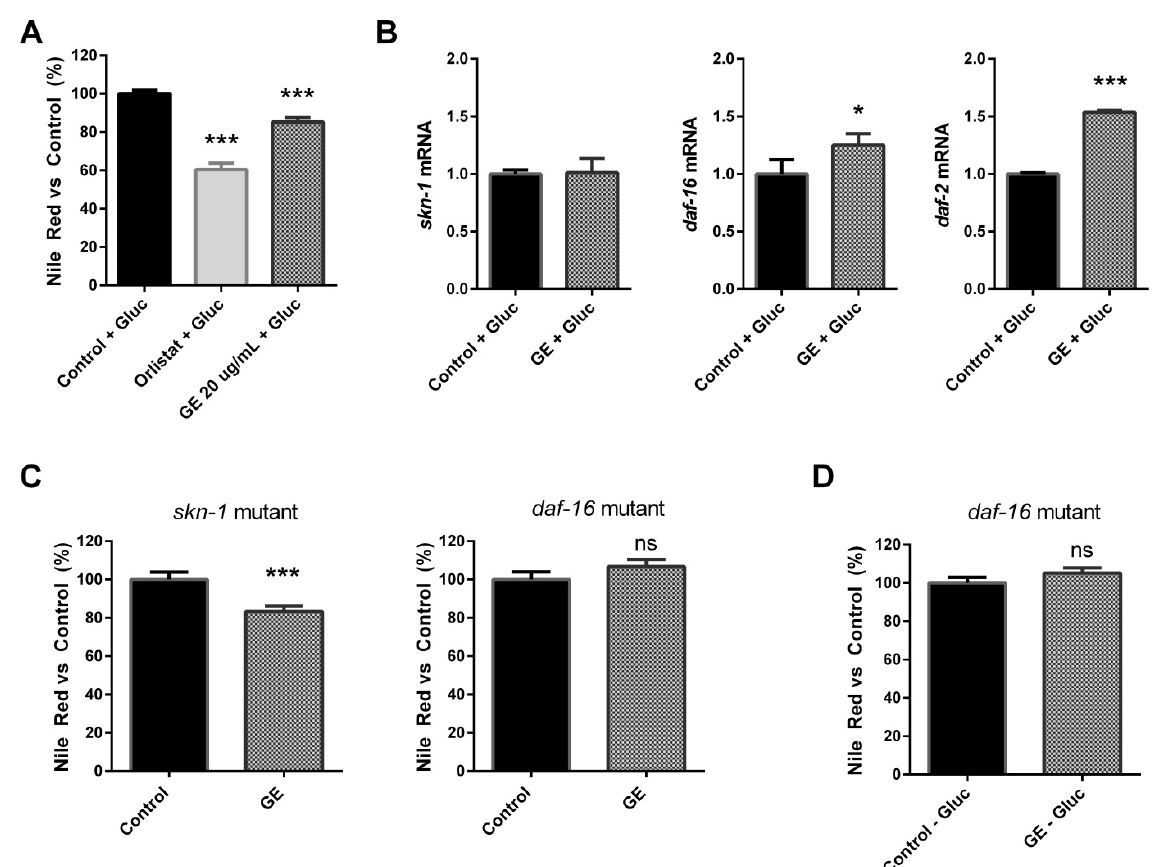
Figure 4. Grifola extract (GE) reduces C. elegans fat accumulation in a glucose-loaded medium through daf-16 and daf-2 up-regulation. ( A ) Nile Red quantification of NGM-control and GE (20 µ g/mL)-treated worms grown in a medium supplemented with glucose (10 mM). Orlistat (6 µ g/mL) was used as the positive control. The results are expressed as the mean ± SEM relative to untreated control worms. ( B ) Expression levels of skn-1 , daf-16 , and daf-2 genes in GE-treated worms in comparison with the untreated control worms grown in a medium with glucose overload. Results are expressed as the fold-difference expression levels of each gene in GE-treated worms compared with the control, calculated with the 2 − ∆∆ Ct method. ( C ) Nile Red quantification of NGM control and GE (20 µ g/mL)-treated worms for skn-1 and daf-16 mutants. ( D ) Nile Red quantification of NGM control and GE (20 µ g/mL)-treated daf-16 mutant worms grown in a medium supplemented with glucose. Significance refers to the effect of the treatments with respect to NGM-control worms (* p < 0.05; *** p < 0.001).